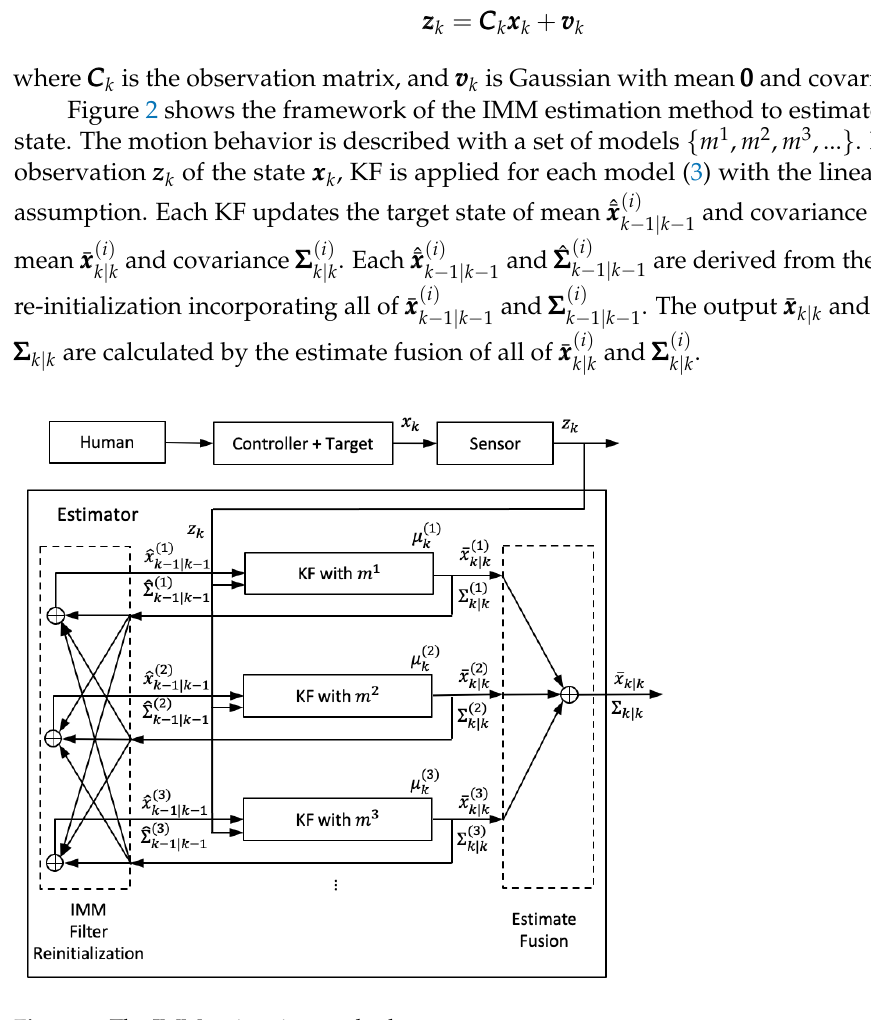
Figure 2. The IMM estimation